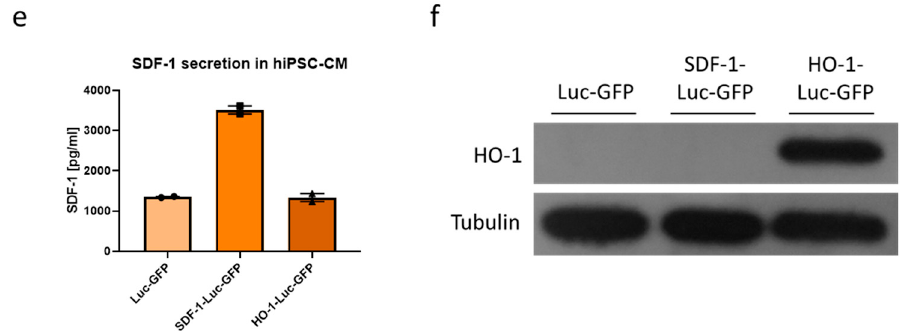
Figure 4. Generation of genetically modified human induced pluripotent stem cell-derived cardiomyocytes (hiPSC-CMs). ( a ) Schematic representation of lentiviral vectors used to transduce hiPSCs. Secretion of SDF-1 α ( b ) and expression of HO-1 ( c ) in transduced hiPSCs. ( d ) Cardiac differentiation efficiency of transduced and sorted hiPSCs measured as percentage of cells positive for cardiac troponin T (cTnT). Secretion of SDF-1 α ( e ) and expression of HO-1 ( f ) in genetically modified hiPSC-CMs.